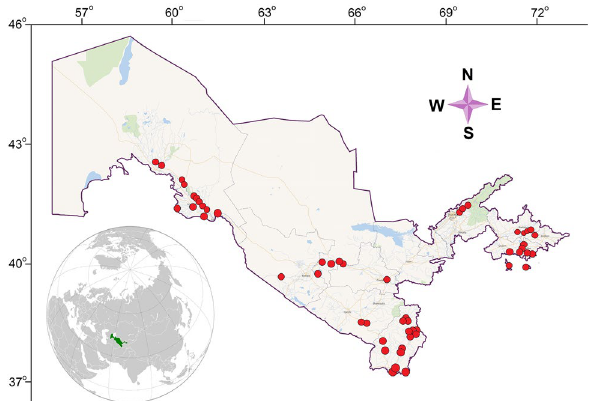
Figure 5. Map of sampling sites in Uzbekistan, 2016–2020. A symbol may cover more than one sampling site. The map was constructed in QGIS 2.18.27 (QGIS Development Team, 2018. QGIS Geographic Information System. Open Source Geospatial Foundation. http:// qgis. org), using free vector and raster map data made available by Wikimedia maps beta (https:// maps. wikim edia. org/). All maps are in the public domain (https:// maps. wikim edia.